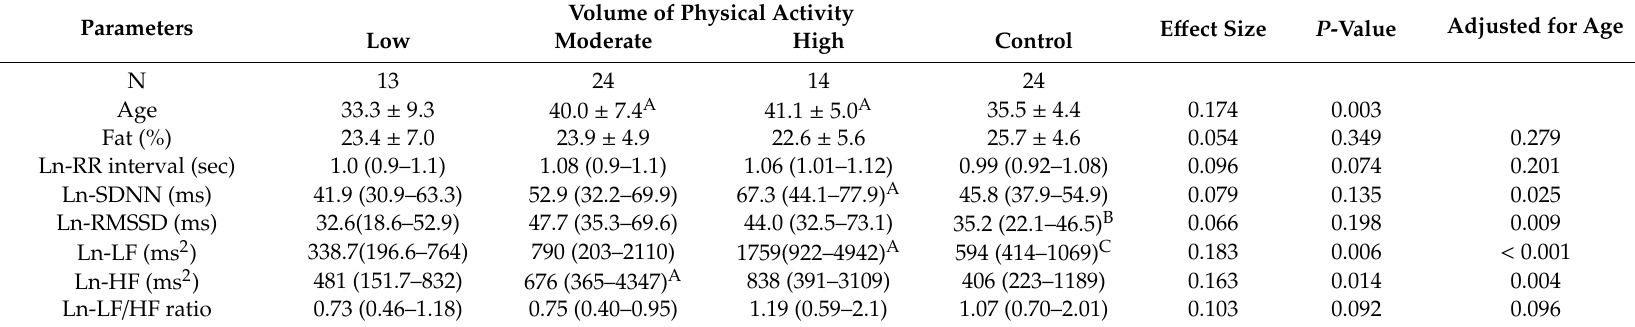
Table 2. Comparison of physical activity (PA) volume between groups (low-, moderate-, high-, and non-active control) for time- and frequency-domain parameters.